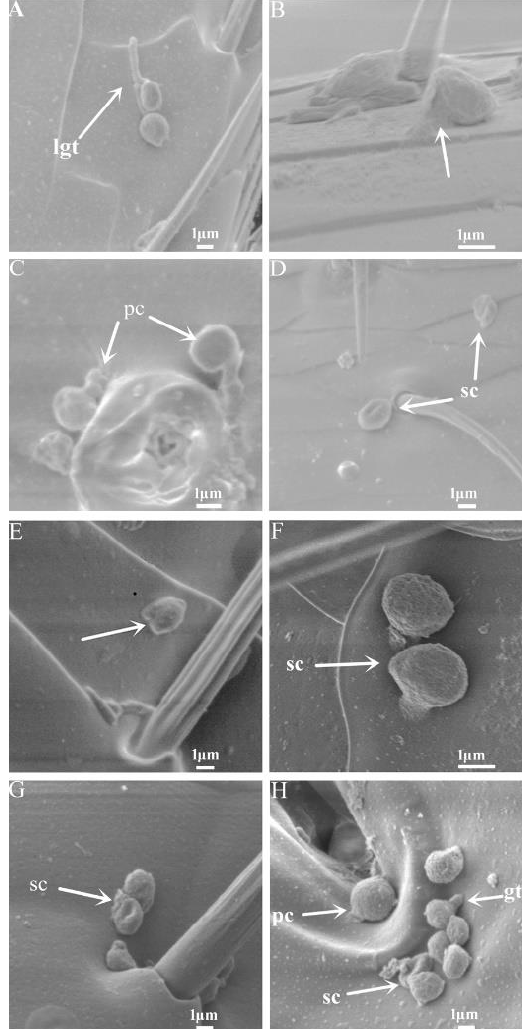
Figure 5. Representative SEM photographs of B. bassiana germ tubes, penetration, and shriveled conidia on the surface of F. occidentalis. ( A ) B. bassiana long germ tubes (lgt), 8 h p.i., ( B ) fungal mucilage production, 12 h p.i., ( C ) penetrating conidia (pc), 12 h p.i., ( D ) shriveled conidia (sc), 18 h p.i., ( E ) fungal mucilage production, 18 h p.i., ( F ) penetrating and shriveled conidia, 18 h p.i., ( G ) shriveled conidia, 18 h p.i., and ( H ) fungal germ tubes, penetrant structures, and shriveled conidia, 18 h p.i.